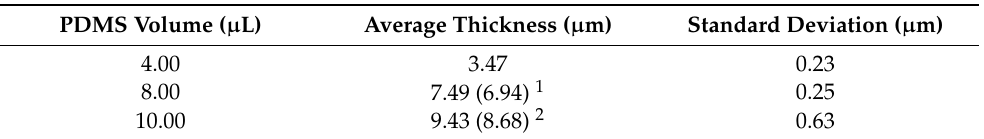
Table 2. Measured membrane thickness values at various PDMS volumes. Numbers in parentheses represent the “calculated” values for the chosen